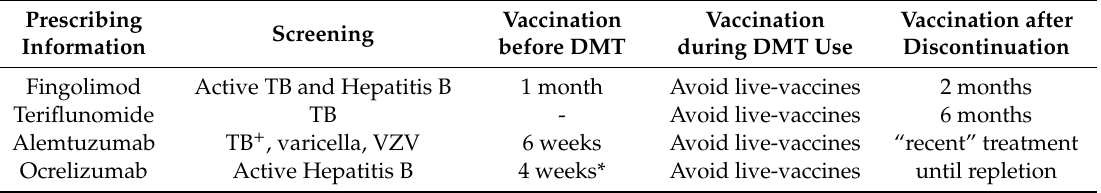
Table 3. Screening and live-vaccination before, during, and after immunosuppressive treatment of MS